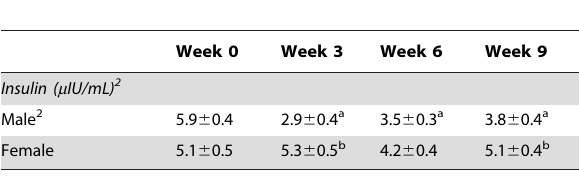
Table 3. Insulin levels of US Army recruits during basic combat training.